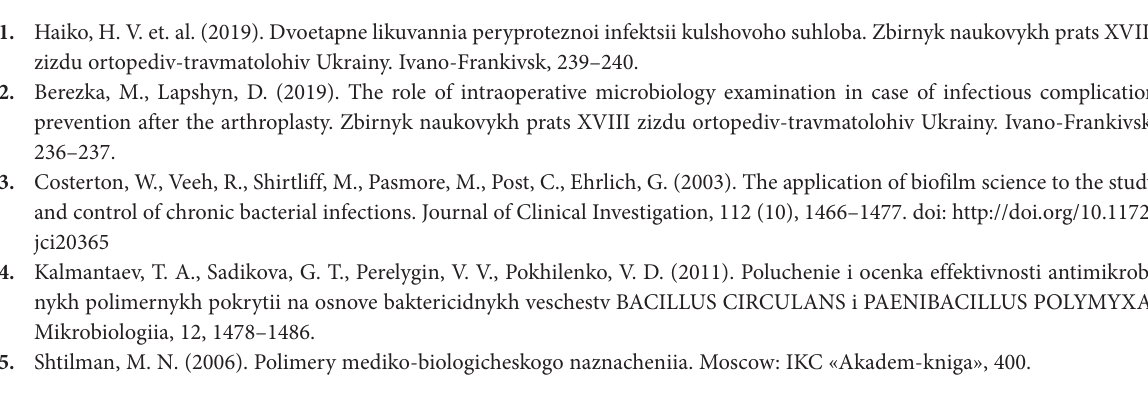
Fig. 1. The third day after seeding, microbial colonies are fixed on titanium implants after contamination In all cases with the surface of anatase and anatase with crystals of silicon dioxide, the first days of the colony of micro- organisms approach 1––2 mm to the edges of the plates, by the third day, the colonies increase in size near the plates, the shape of the implants is repeated at a distance of 1–0.5 mm, but do